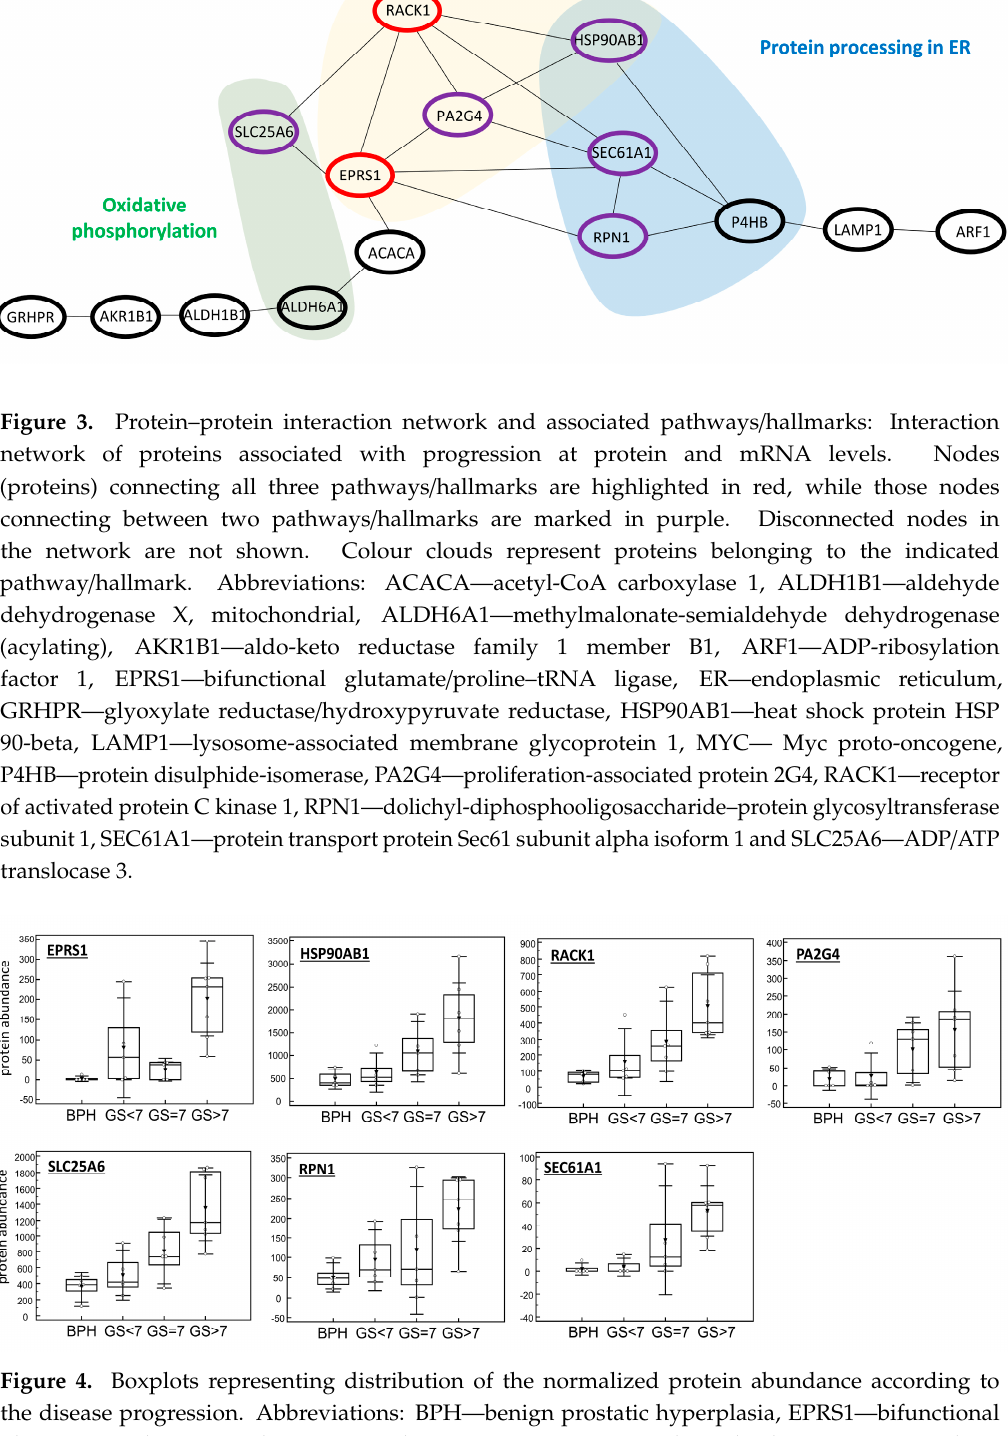
Figure 4. Boxplots representing distribution of the normalized protein abundance according to the